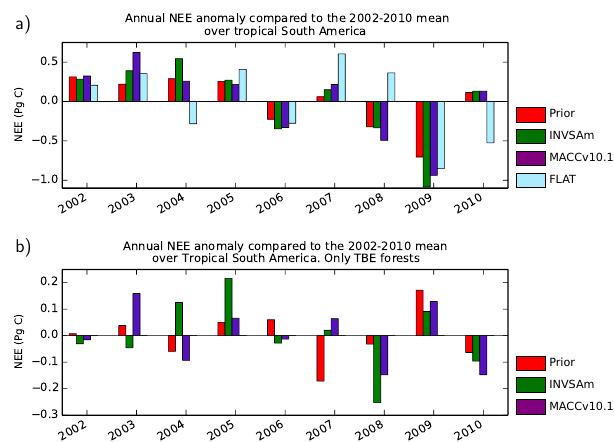
Figure 9. (a) Annual NEE anomaly compared to the mean of 2002–2010; estimates for the whole study region. (b) Annual NEE anomaly compared to the mean of 2002–2010; estimates for the area dominated by TBE